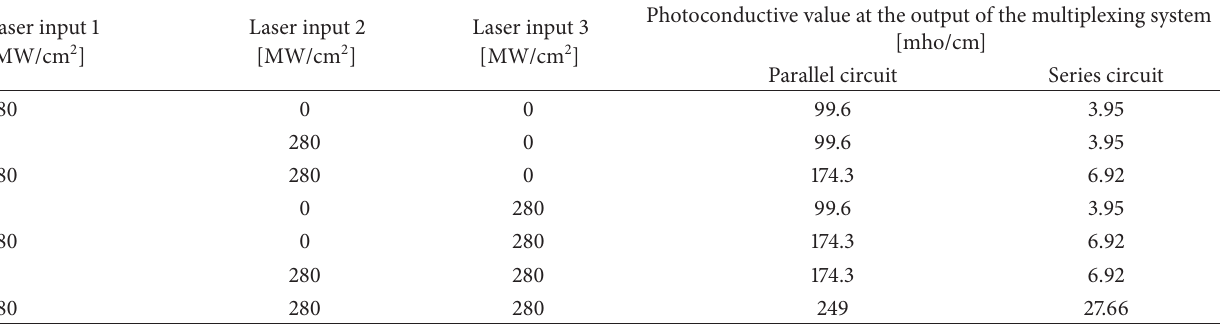
Table 1: Photoconductive multiplexed results.